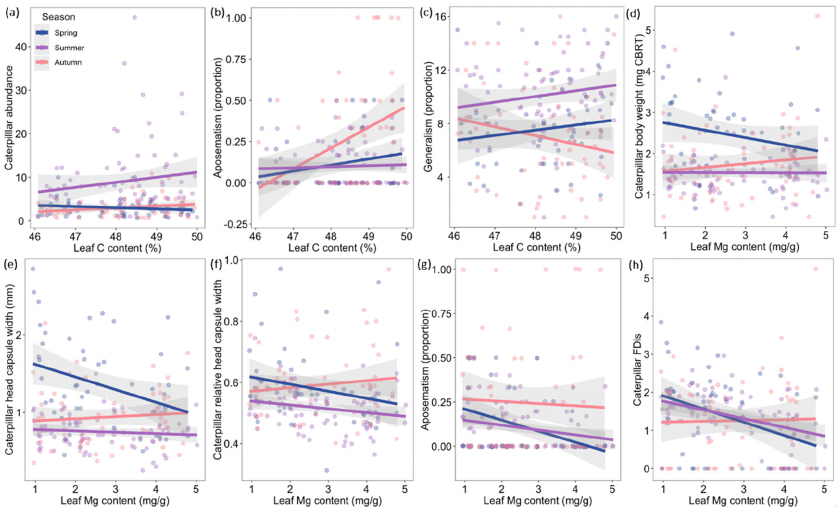
Figure 2. Relationships between leaf traits (leaf C and Mg content) with caterpillar ( a ) abundance and traits, ( b ) body weight, ( c ) head capsule width, ( d ) relative head capsule width, ( e , f ) aposematism, ( g ) generalism, and ( h ) FDis.